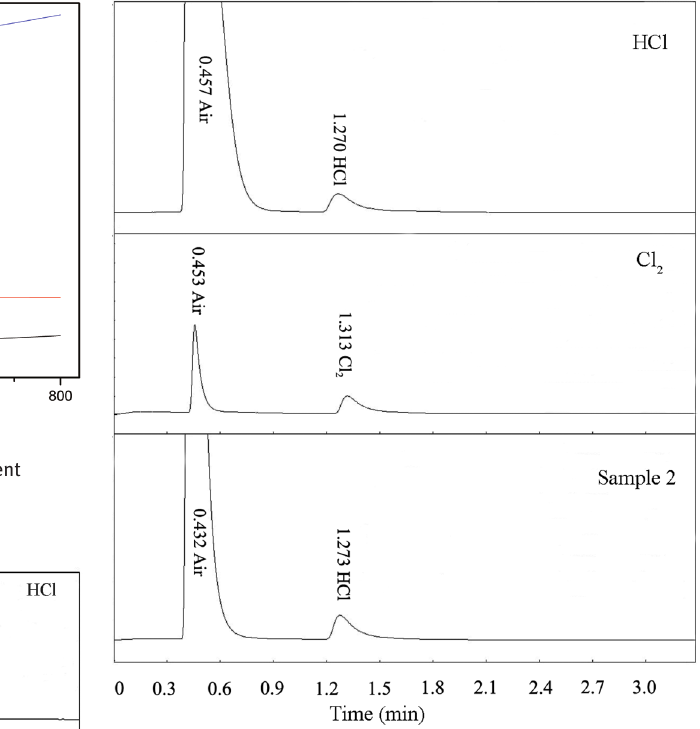
Fig. 9: GC chromatograms of gas samples obtained under atmosphere of water vapor with air